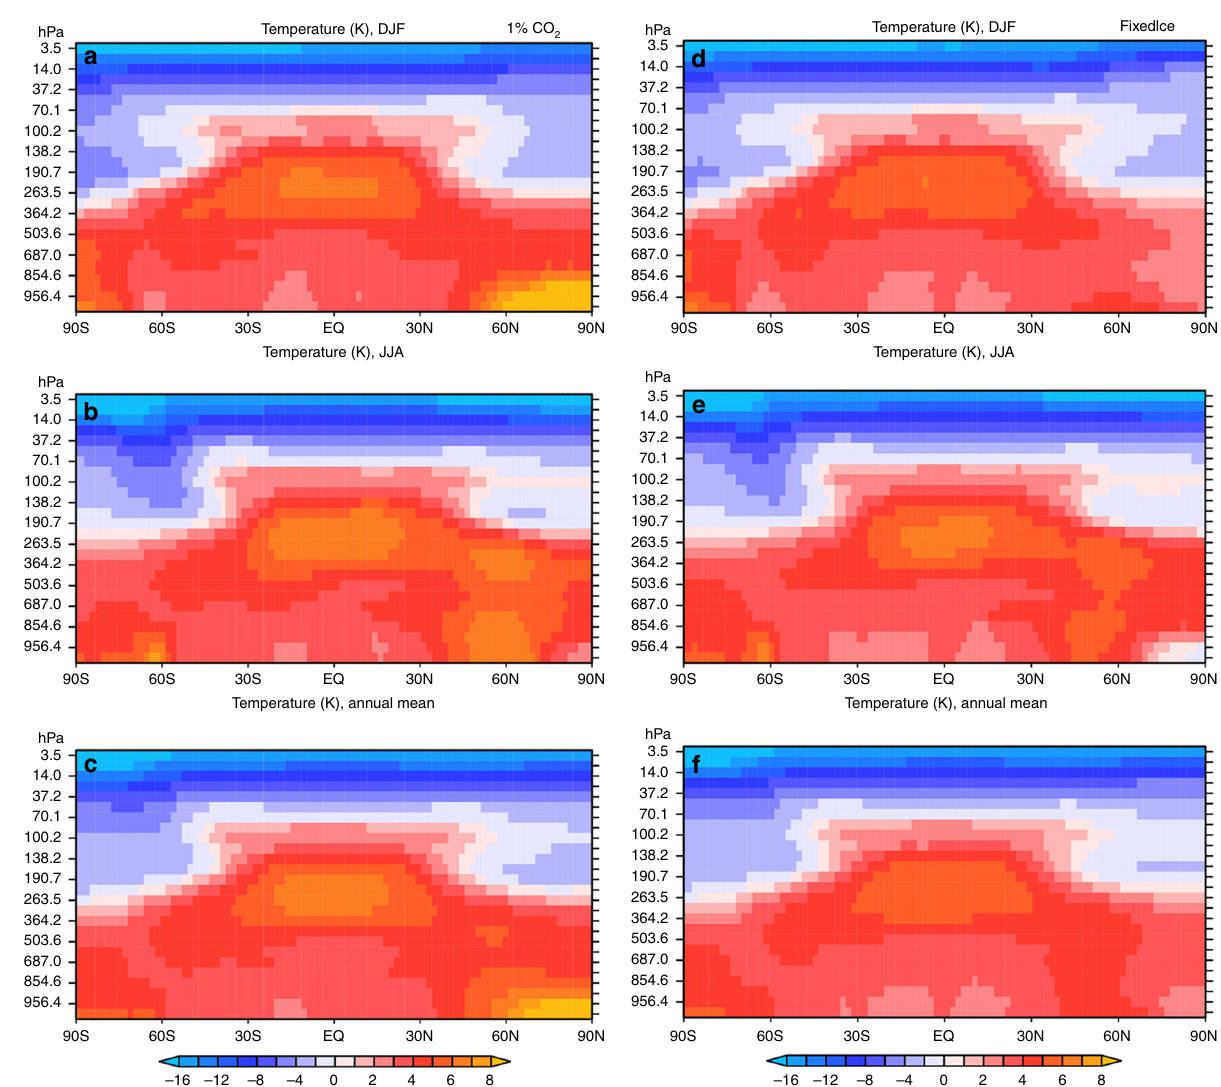
Fig. 9 Height – latitude distributions of zonal-mean temperature change from the CESM simulations. a - c The standard 1% CO 2 run. d - f FixedIce run. The temperature change is relative to the control-run climatology and is around the time of the second doubling (i.e., years 131 – 150) of the pre-industrial CO 2 level. Top row: for December – January – February (DJF). Middle row: for June – July – August (JJA). Bottom row: for annual-mean. The change patterns are similar around the 1 st and 3 rd doubling of the pre-industrial CO